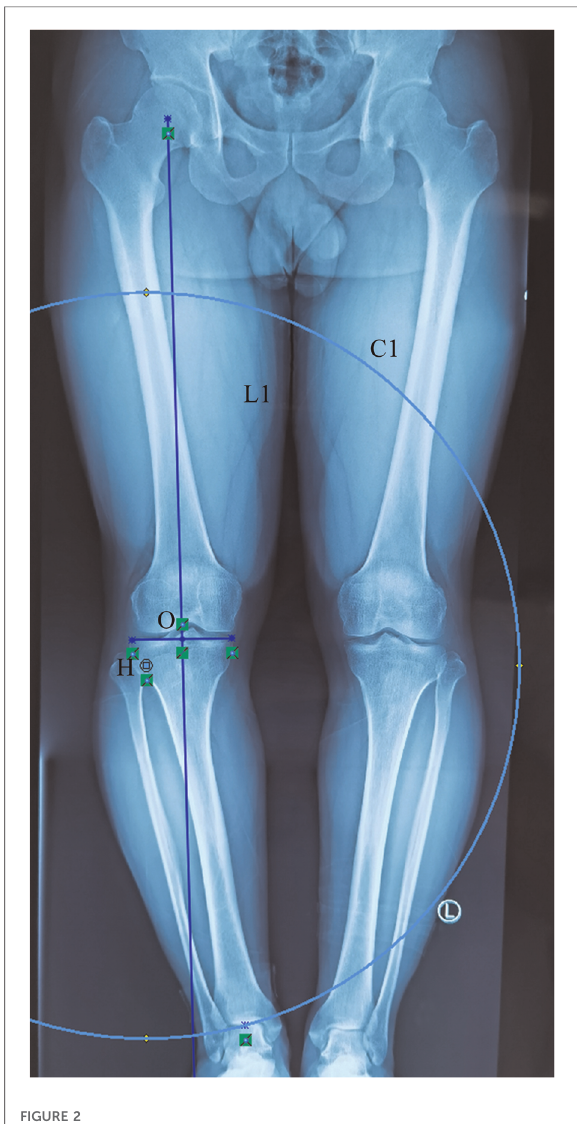
FIGURE 2 The site 15-mm distal to the lateral tibial plateau and 8-mm medial to the lateral cortex of the proximal tibia were selected as the hinge point (H). With point H as the center, a concentric circle was drawn through the center of the ankle joint